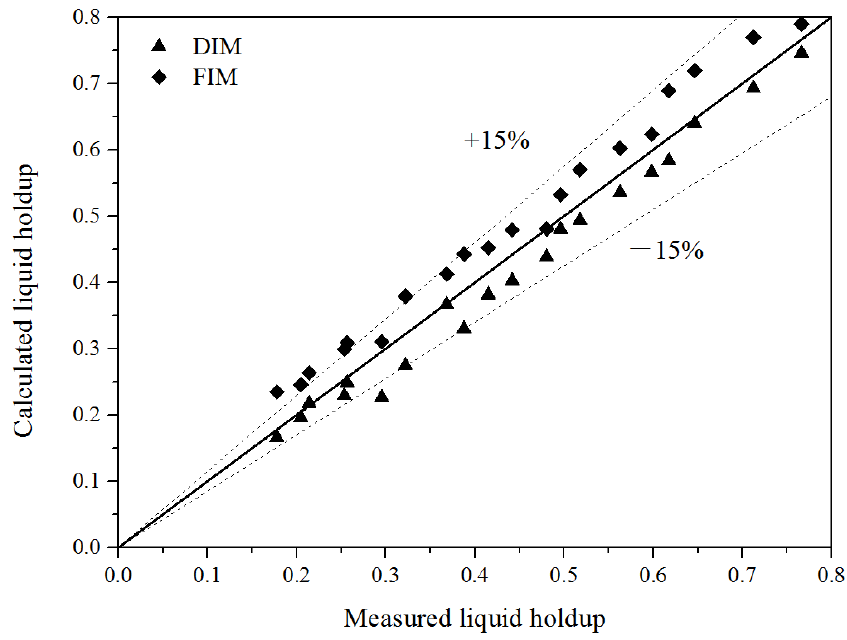
Figure 4. Comparison of predictions and experiment of liquid holdup for the No. 1 experiment.